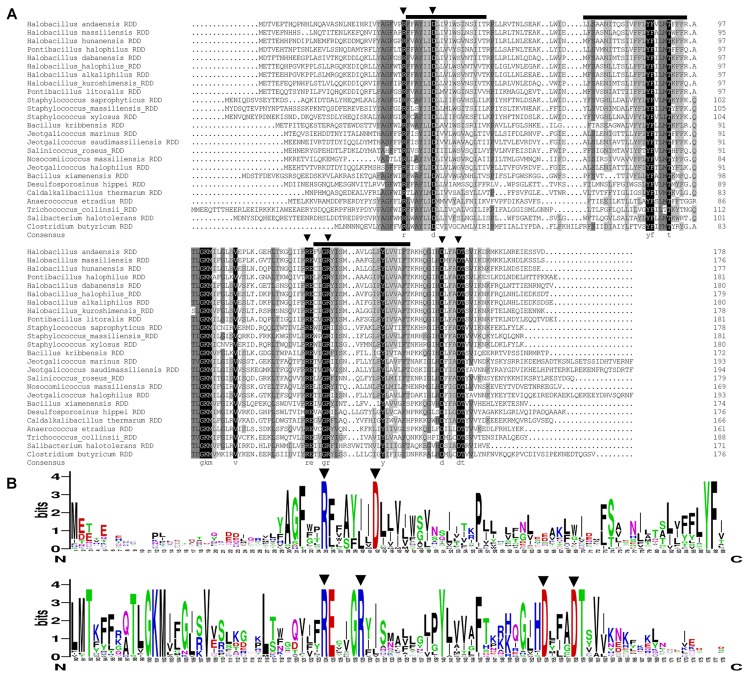
Alignment of RDD with all its selected holomogs and its web-based amino acid sequence logo. (A) Alignment of RDD with all its selected holomogs. RDD was aligned with all its selected homologs with 26–74% identities within the neighbor-joining phylogenetic tree (Figure 9) to show its conserved amino acid residues. Accession.version numbers and hosts of the selected homologs are shown in the neighbor-joining phylogenetic tree of Figure 9. Shading homology corresponds to 100% (black), ≥75% (gray), ≥50% (light gray), and <50% (white) amino acid identity, respectively. The three putative transmembrane segments are marked with bold lines above the alignment. (B) RDD sequence logo. An amino acid sequence logo was also created by submitting the multiple sequence alignment of RDD with the above-mentioned 24 homologs to the website http://weblogo.berkeley.edu/. The heights of amino acid symbols stand for their conservation in the multiple alignment. The highly conserved arginine (R) and aspartate (D) residues between RDD and all its selected homologs with 26–74% identities are highlighted with the downward filled triangles above the alignment (A) or sequence logo (B).